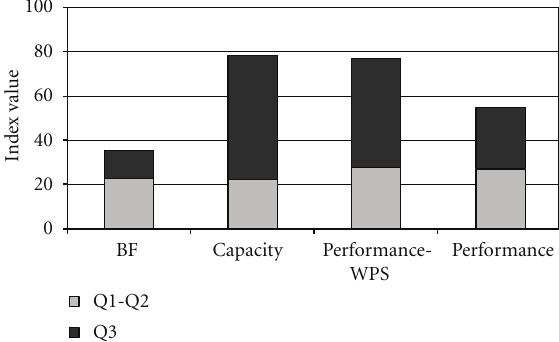
Figure 2: Distribution of mild-severe and very severe-complete problems among subjects with severe